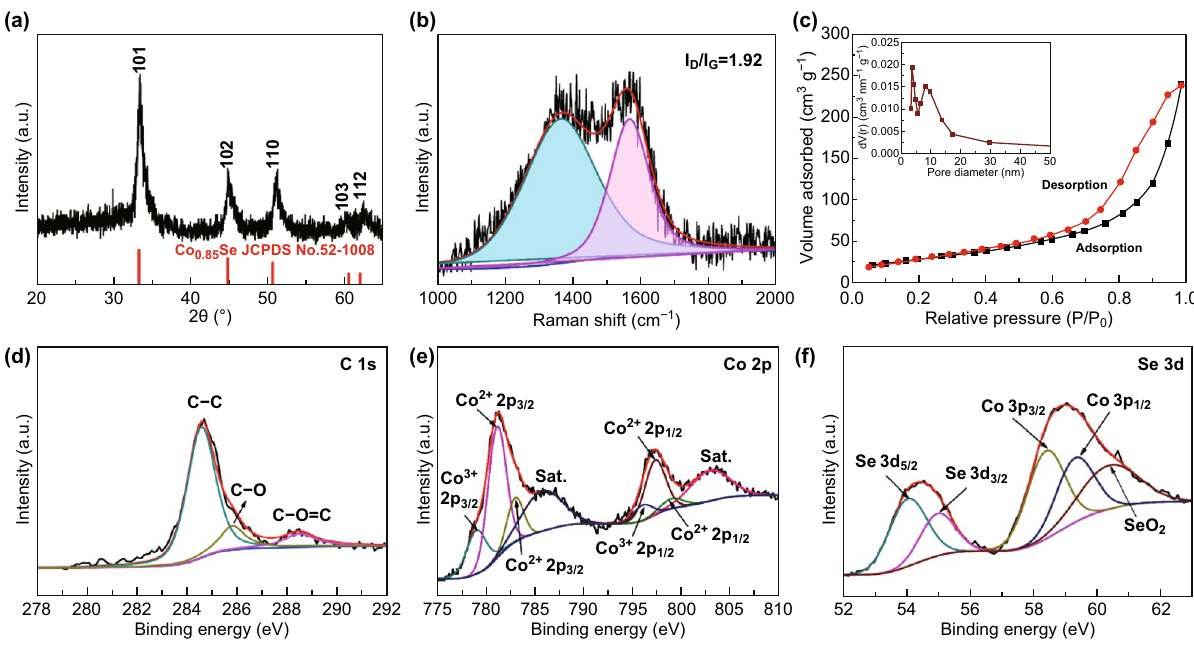
Fig. 3 Structural characterizations of the as‑synthesized Co 0.85 Se‑QDs/C‑20. a XRD pattern. b Raman pattern. c N 2 adsorption isotherm and pore‑size distribution. Peak deconvolutions of the XPS spectra: d C 1 s , e Co 2 p , f Se 3